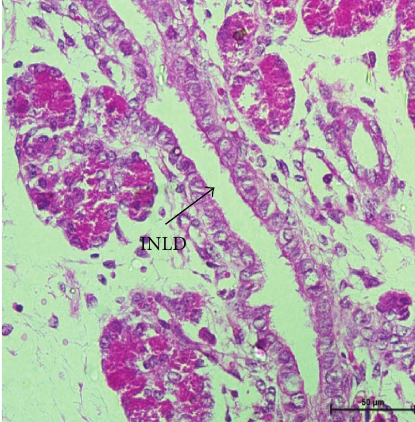
Figure 11: Electron micrograph of 48cm CVRL (182 days) foetus showing irregular shape nucleus (N) and cell membrane (CM) of centroacinar cell ×